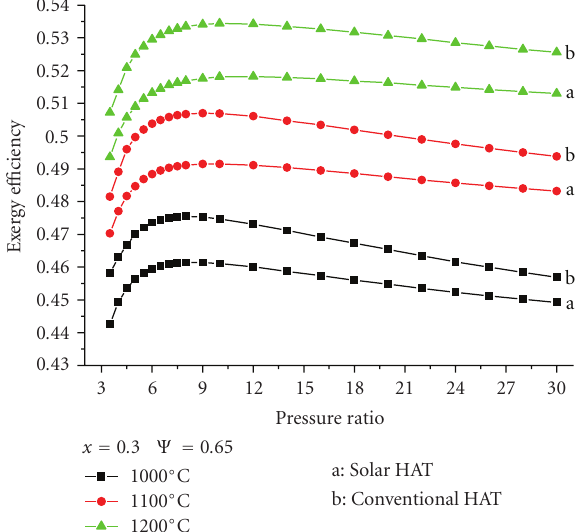
Figure 4: Exergy e ffi ciency variation with pressure ratio.